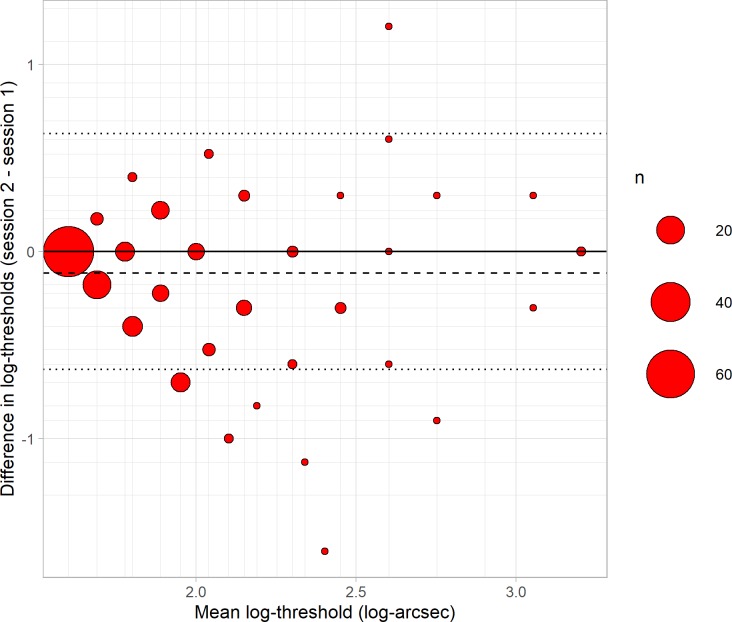
Difference between log-thresholds in the two sessions (second minus first) plotted against means, for 187 children aged 3–11 years.The size of the symbol indicates the number of children (see legend). Positive differences indicate worse performance on re-test, negative differences indicate better; no change is indicated by the solid black line. Dashed line shows the mean of the differences, dotted lines show the 95% limits of reliability about 0. The minor grid lines indicate the possible mean and differences given the available values on the Randot Preschool.